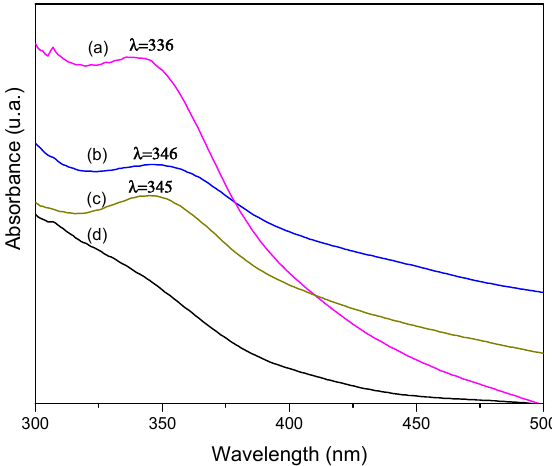
Figure 6. UV-Vis spectra of aqueous solutions filtrated from the original reaction fluids; (a) CCuNP10.0, (b) CCuNP5.0, (c) CCuNP2.5, and (d) CuSO 4 .